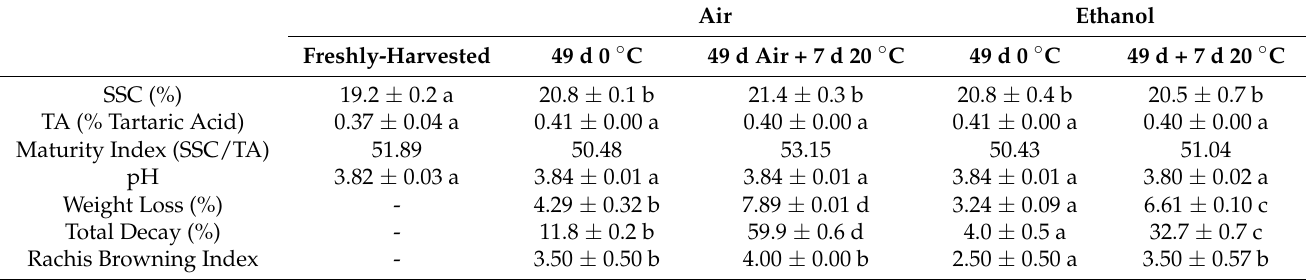
Figure 1. Appearance of It 680–31 grape bunches treated and non-treated with ethanol stored at 0 °C for up to 49 days. Table 1. Soluble solids content (SSC), titratable acidity (TA), pH, weight loss, total decay, and rachis browning index of It 681–30 table grapes non-treated and treated with ethanol for 49 days at 0 °C and after the shelf-life period (49 d + 7 d at 20 °C).